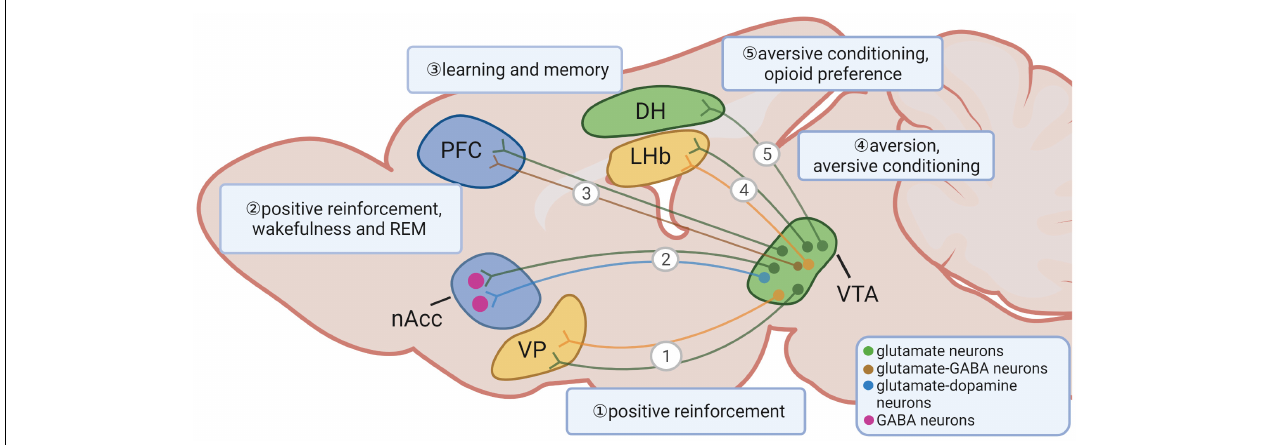
FIGURE 1 | Long-range projections of ventral tegmental area (VTA) glutamate neurons and their functions. VTA glutamate neurons project to the ventral pallidum, the nucleus accumbens, the prefrontal cortex, the lateral habenula and the dorsal hippocampus. The shapes and locations can only represent the general structure and location. The segregated lines with arrows represent a simplified diagram of general projection patterns rather than indicating an existence of parallel and non-overlapping projection patterns from the indicated